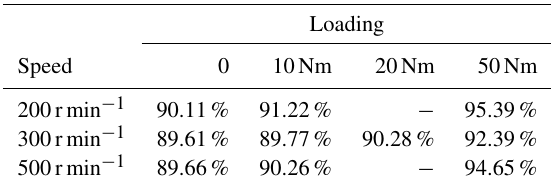
Figure 3. Experimental platform of novel multistage face gears transmission mechanism (1: Variable frequency drive motor, 2, 4: ZJ series torque speed sensor, 3: Multistage face gears box model machine, 5: Magnetic powder loader, 6: Three-compartment stabi- lized voltage supply, 7: Control and test system). Table 2. Average transmission efficiency in the deceleration pro- cess.